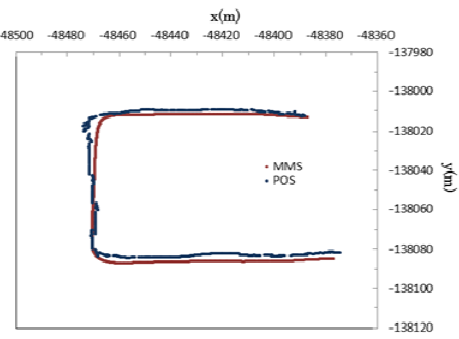
Figure 8. Result of position with POS sensor fusion